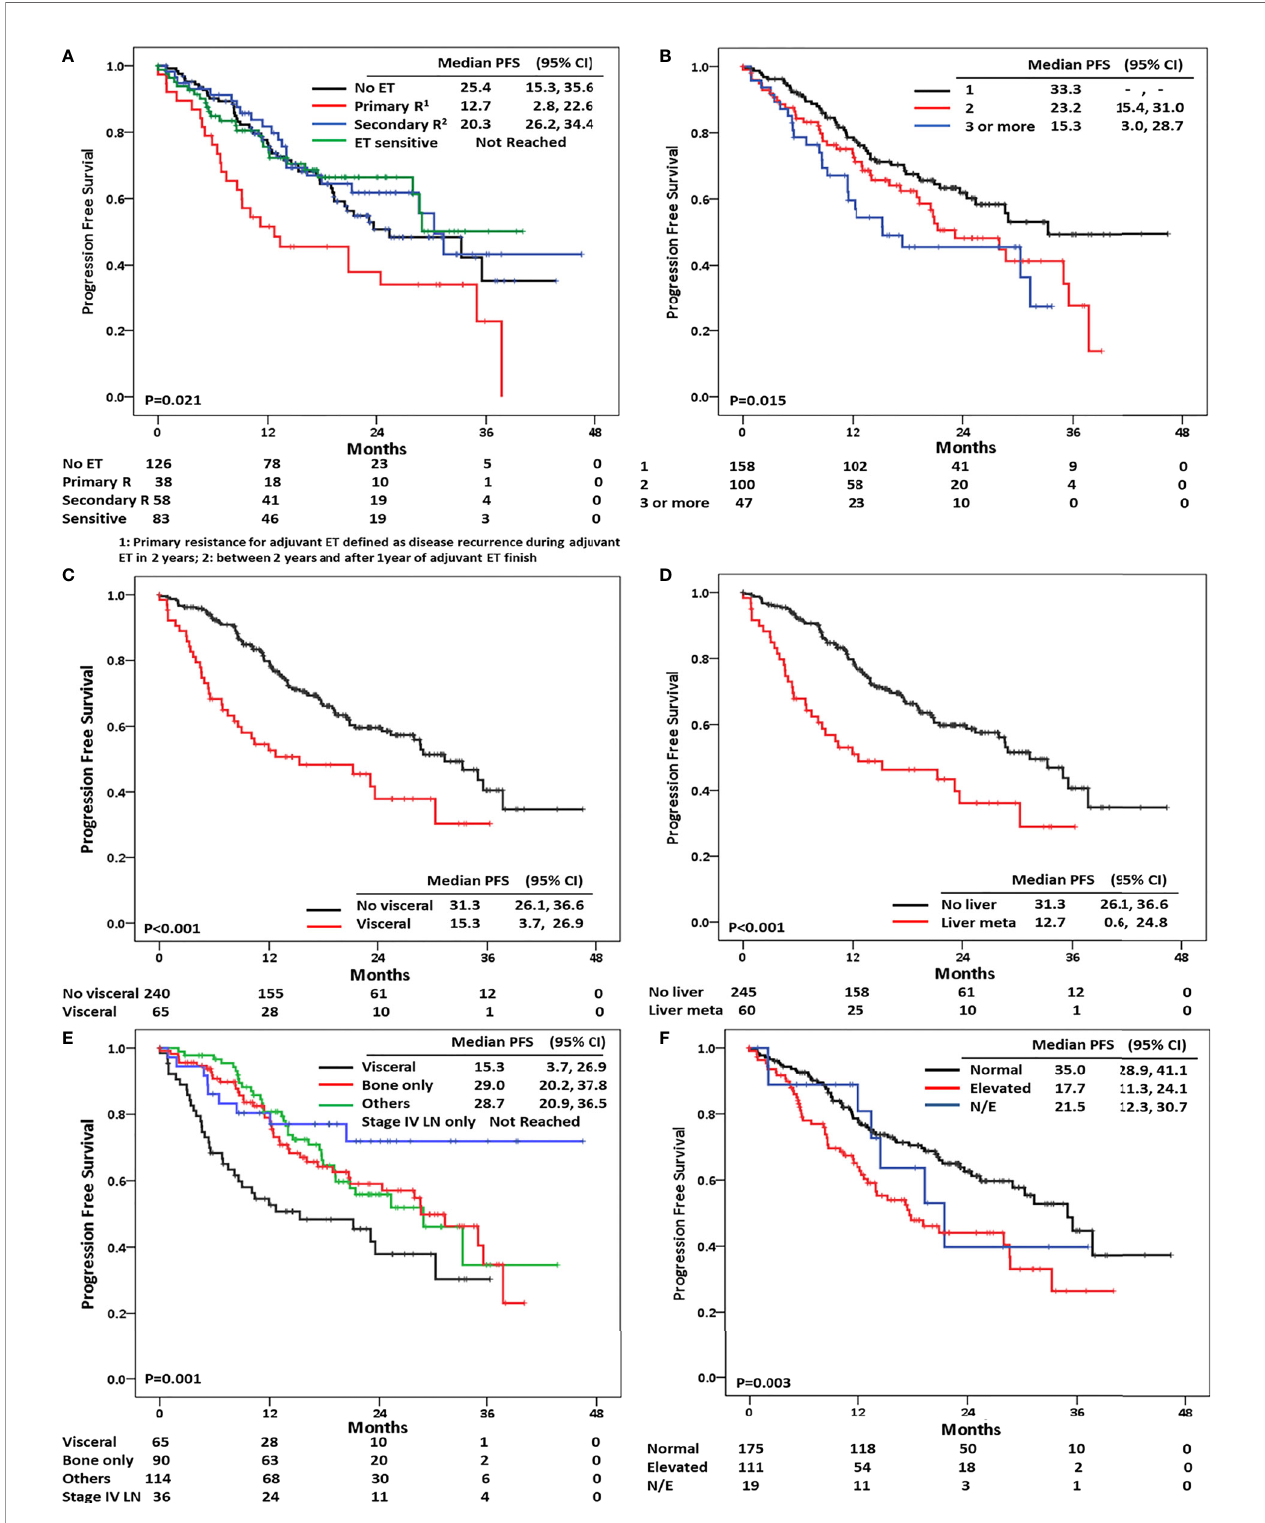
FIGURE 3 | Progression-free survival according to (A) response to adjuvant endocrine treatment, (B) number of metastatic sites, (C) visceral metastasis, (D) liver metastasis, (E) metastatic sites, and (F) baseline CA-15-3 level.